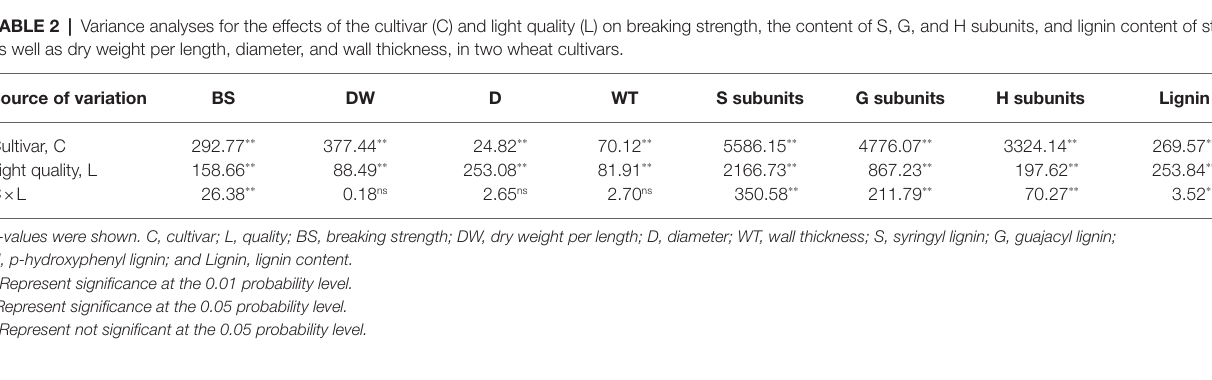
TABLE 3 | Effect of light quality in wheat population on breaking strength in 2018–2019 and 2019–2020 growing seasons.